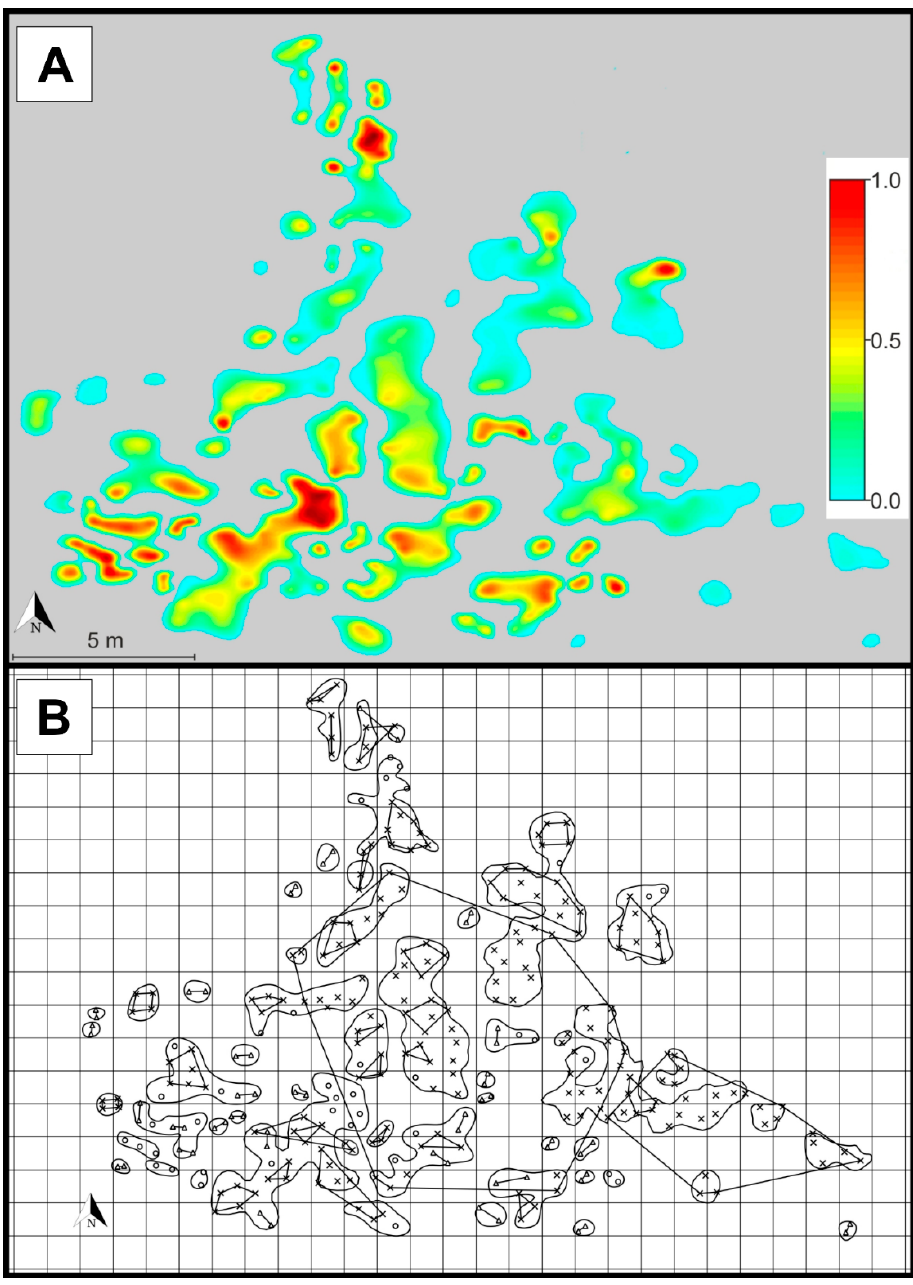
Figure 6. ( A ) Density map showing the spatial distribution of genotypic richness (given by the color scale on the right) in the population’s largest group of patches (eastern group). The patches are colored, while the areas without S. brachyodon are in grey. Darker reddish colors indicate areas characterized by high levels of genotypic richness, while lighter greenish colors indicate areas characterized by lower levels of genotypic richness. ( B ) Spatial distribution map of the sampled S. brachyodon ramets in the population’s largest group of patches (eastern group) shown over a 1 m 2 resolution grid. The individual genets that comprise three or more sampled ramets are indicated by convex hull polygons, while the irregular closed shapes indicate the patches of ramets. The sampled ramets that are characterized by a unique MLG are represented by circles, pairs of ramets that belong to the same genet are represented by triangles, and three or more ramets that belong to the same genet are represented by “x” mark and positioned within an associated polygon.